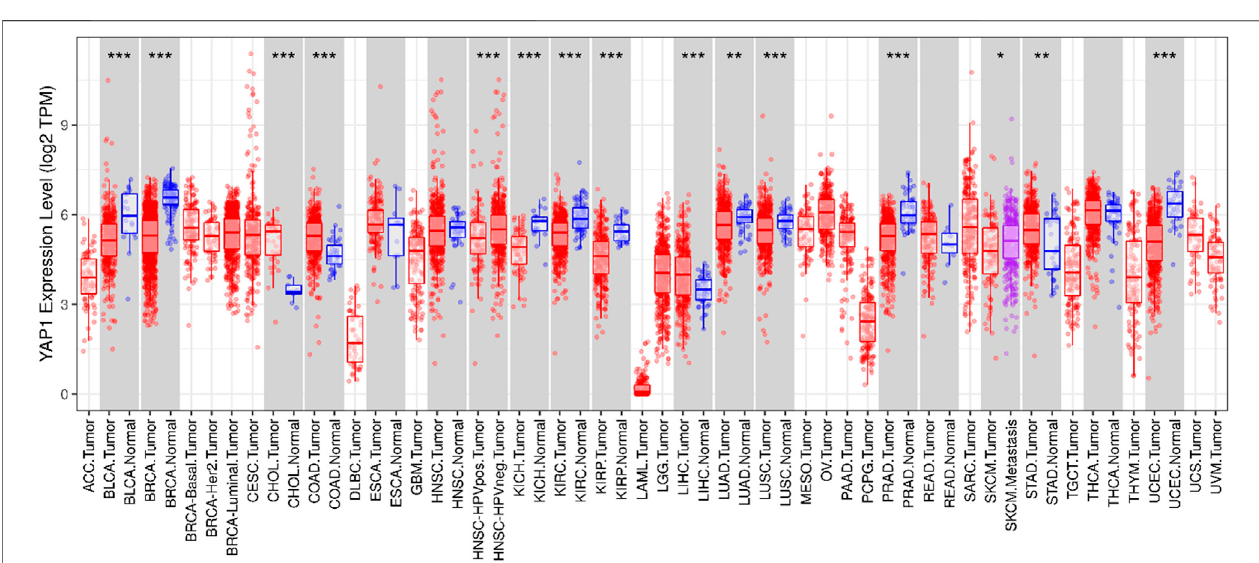
FIGURE 2 | YAP1 expression levels in different tumor types based on data from TCGA were determined using TIMER. * p < 0.05, ** p < 0.01, *** p < 0.001.